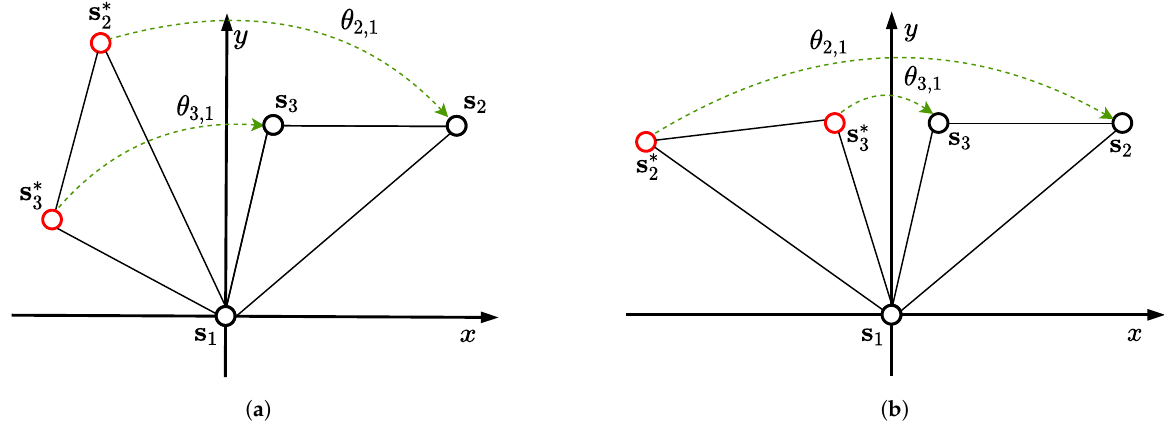
Figure 2. Illustration of angle θ i ,1 given in (27) using three nodes with true locations s i and solved ambiguous locations s ∗ ( a ) rotation ambiguity and θ 2,1 = θ 3,1 ; ( b ) flip ambiguity and θ 2,1 (cid:54) = θ 3,1